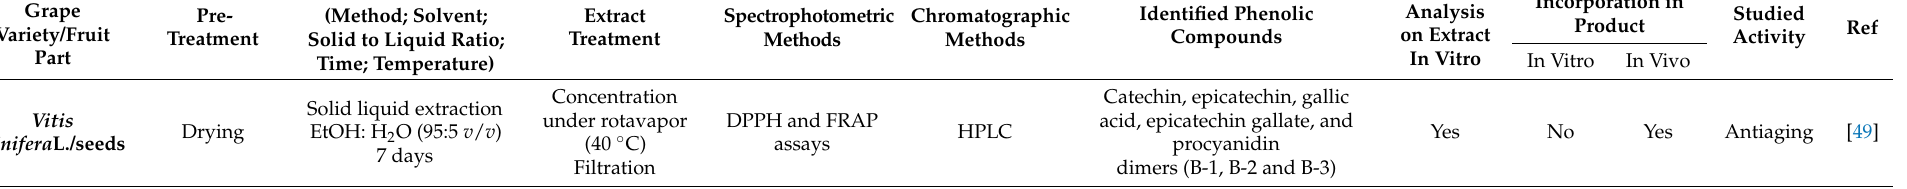
Table 1. Grape variety, pre-treatment, extraction parameters, extract treatment, analytical methods and identified compounds for the corresponding studied activities in cosmetics. Grape